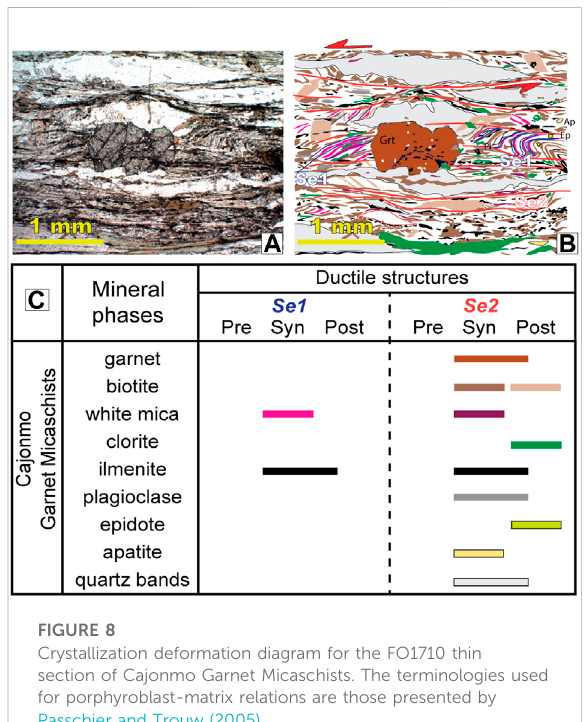
FIGURE 8 Crystallization deformation diagram for the FO1710 thin section of Cajonmo Garnet Micaschists. The terminologies used for porphyroblast-matrix relations are those presented by Passchier and Trouw